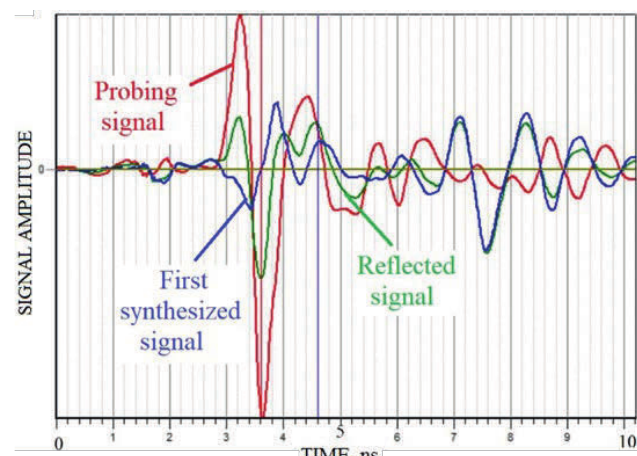
Fig. 7. First stage processing results.